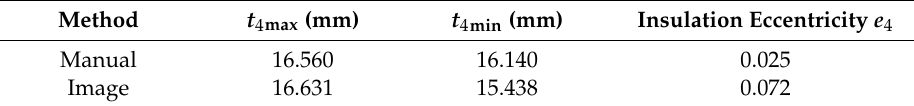
Figure 25. Cutting burrs of outermost contour. Table 5. Eccentricity measurement of insulation layer.